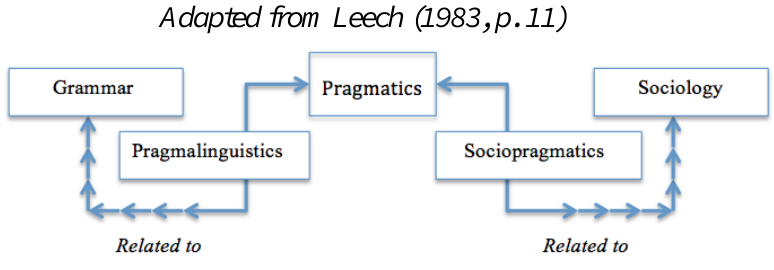
Distinction between Pragmalinguistics and Sociopragmatics Adapted from Leech (1983, p.